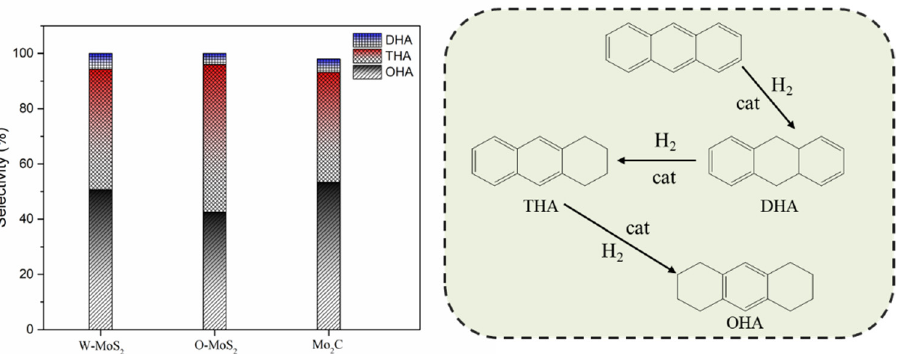
Figure 8. Product selectivity and hydrogenation pathway of anthracene. DHA, THA and OHA refer to 9, 10-dihydroanthracene, 1, 2, 3, 4-tetrahydroanthracene, and 1, 2, 3, 4, 5, 6, 7, 8-octahydroanthra- cene.